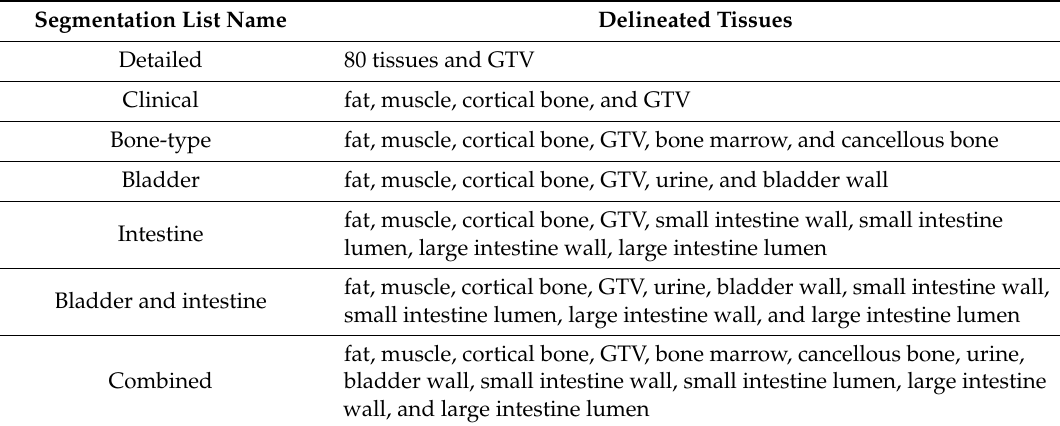
Figure 3. Schematic representation of the di ff erent segmentations, sizes, and locations of the GTV (gross target volume). Each color represents a delineated tissue. The virtual model used for displaying the di ff erences between segmentations is Ella. The location and size of GTV are illustrated in Ella and Duke. As presented in the di ff erent segmentations, HTV was always larger than the GTV, since it contains the GTV plus a margin. For all the GTV, approximately the same margin was applied to create HTV (hyperthermia target volume). This way, each GTV has a corresponding HTV. Table 1. Tissues delineated in each segmentation.